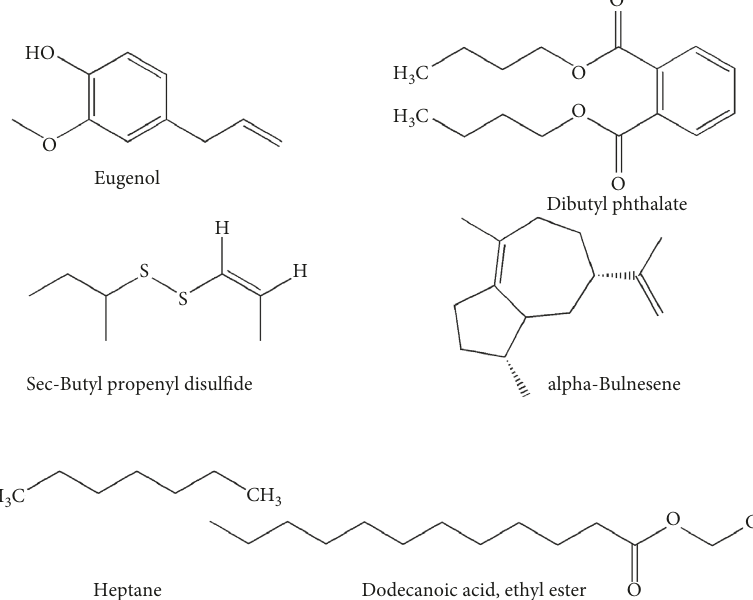
Figure 6: Some less-common compounds detected by GC-MS